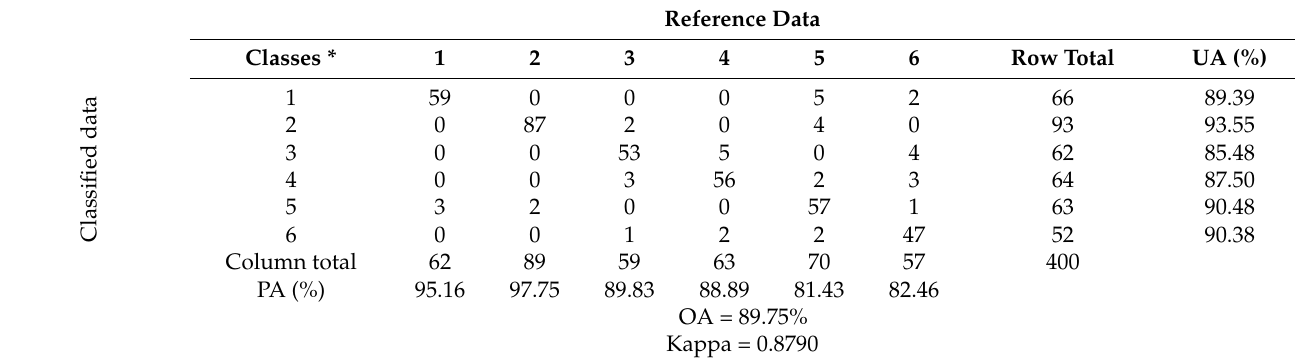
Table A3. Error matrix relating to accuracy assessment of the classified LULC map of 1996.